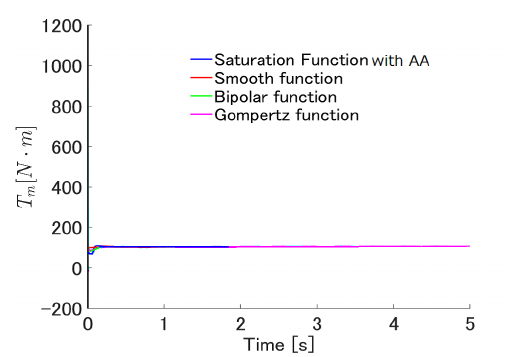
Figure 18. Time response of driving torque on icy road